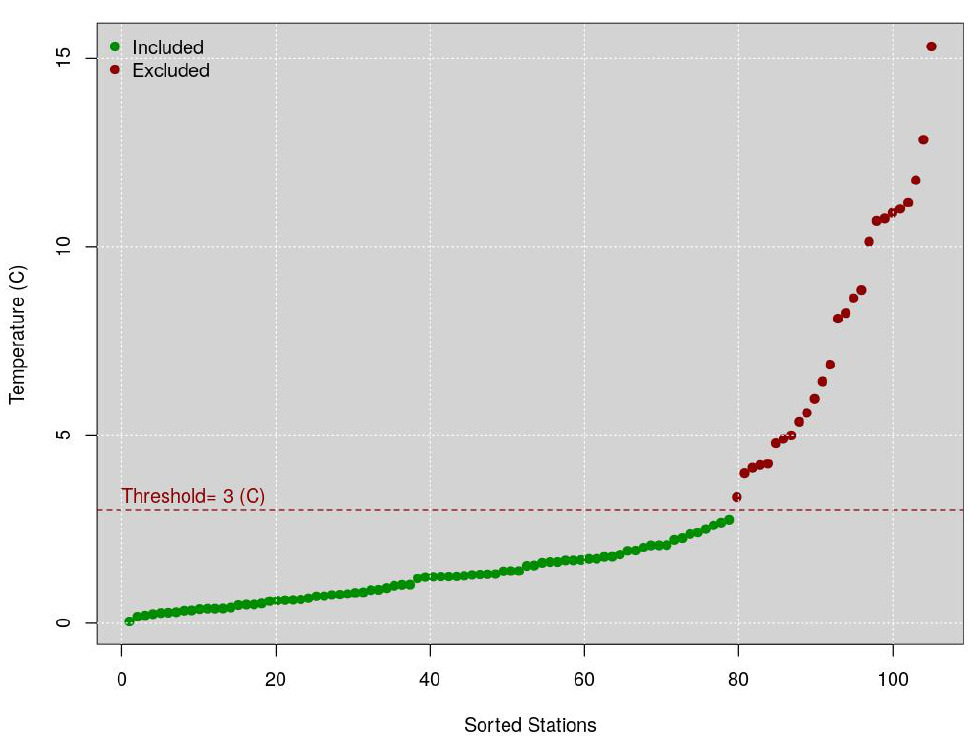
Figure 1. WU data quality control—QQ graph of the average annual temperature of the PWSs. The dotted red line represents the maximum threshold (3 °C), value from which the average of a PWS can deviate from the mean temperature of the stations to be included, otherwise it will be